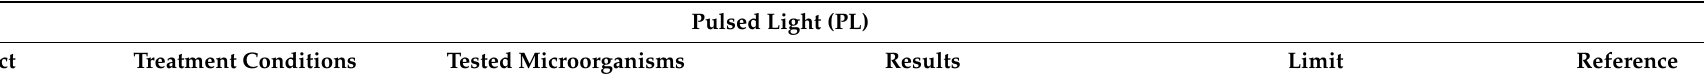
Table 3. Application of pulsed light (PL) and ultrasound (US) technology to fish products; main results and limitations of the technologies